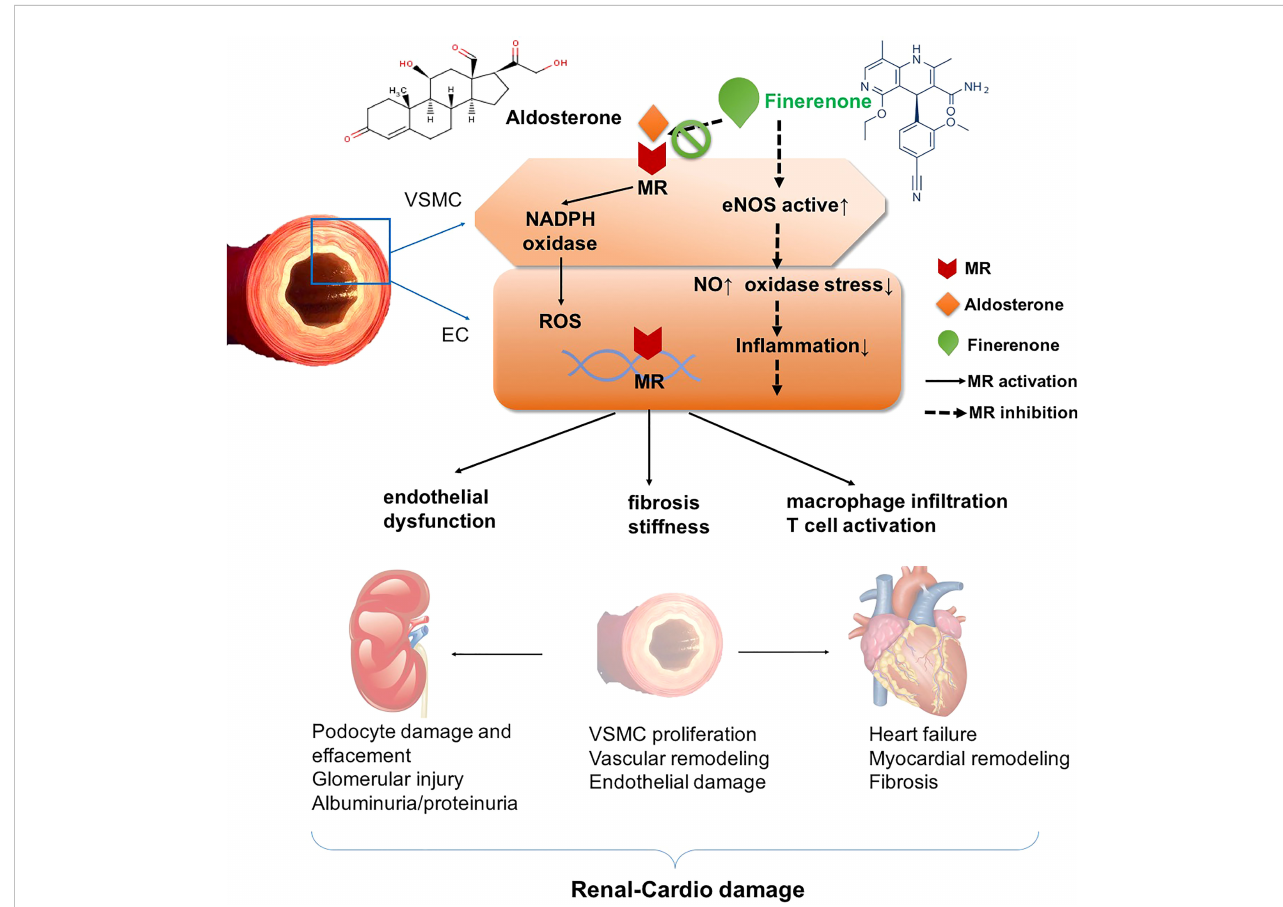
FIGURE 1 Mechanism of renal-cardio damage by mineralocorticoid receptor (MR) overactivation. MR activation plays important role in promoting NADPH oxidase, and enhancing ROS accumulation in VSMCs and ECs, and induces oxidase stress. In this way, MR agonist such as aldosterone results in endothelial dysfunction, macrophage in fi ltration and T cell activation, in fl ammatory progenitors including cytokines collection, and acts on VSMC leading to fi brosis and stiffness. MR activation affects kidney, aggravates podocyte damage and effacement, glomerular injury, and VSMC proliferation and endothelial damage, leading to vascular remodeling. On heart, MR activation exacerbates heart failure, myocardial remodeling and fi brosis. On contrast, MR antagonist fi nerenone blocks the binding of aldosterone and MR, then attenuates those pathophysiological progressions. In this way, fi nerenone shows renal-cardio protective effect. MR, mineralocorticoid receptor. EC, endothelial cells. VSMC, vascular smooth muscle cells. ROS, reactive oxygen species. NADPH, nicotinamide adenine dinucleotide